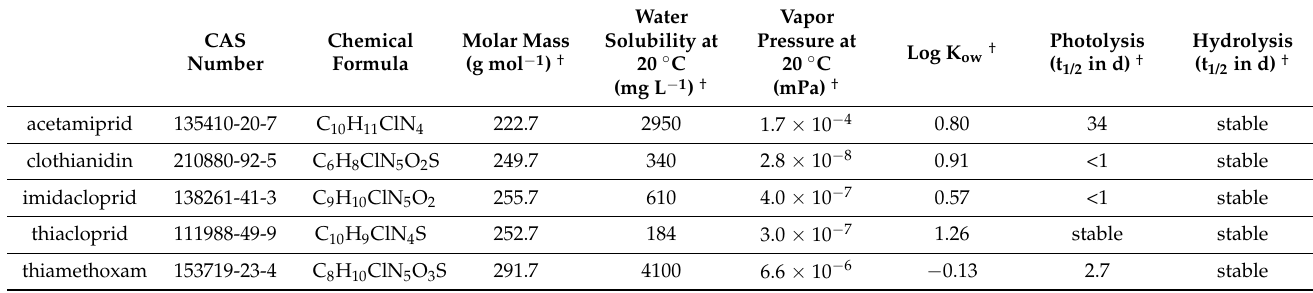
Table 1. Chemical properties of the tested NEO